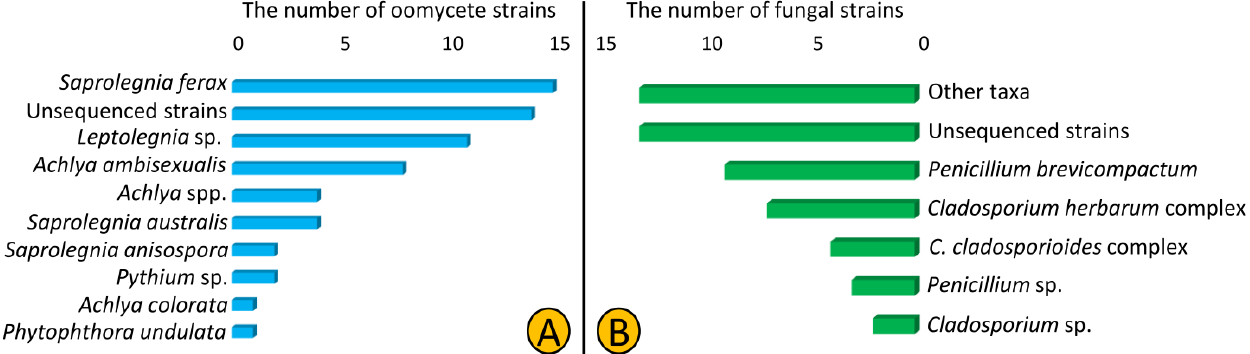
Figure 2. Phylogenetic tree of obtained Saprolegniales and Peronosporales isolates inferred from the analysis of the aligned ITS1-5.8S-ITS2 sequences (666 bp) using the maximum likelihood method from strains in this study and validated sequences from GenBank. The numbers next to the branches show bootstraps values ≥ 50%. Ph. undulata (MF115501, MF115240, and MF115224) was considered an outgroup.